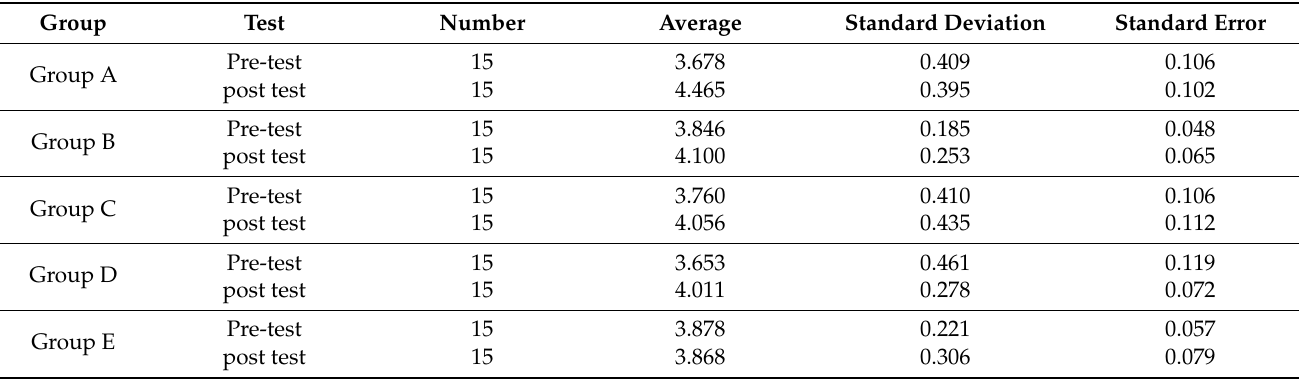
Table 2. Summary table of the overall pre- and post-test mean and standard deviation of “physical and mental health” for middle-aged and elderly people in the community.